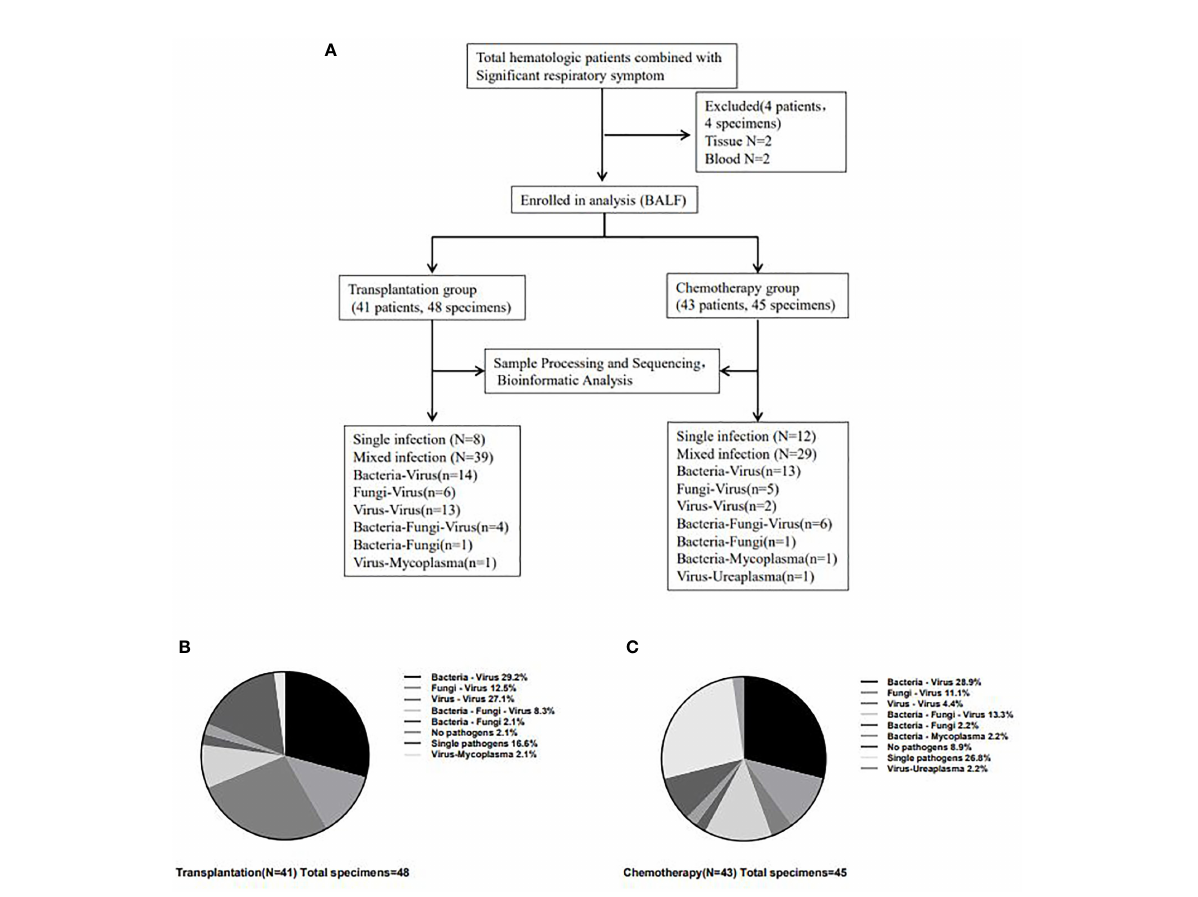
FIGURE 2 Detection of infectious pathogens by mNGS in transplantation group and chemotherapy group. The fl ow chart for inclusion of analyzed patients (A) and the most common type of infection in patients in the transplantation (B) and chemotherapy (C) groups was the mixed infection of bacteria-virus. And the mixed infection of virus-virus in the transplantation group was signi fi cantly higher than that in the chemotherapy group (27.1% vs 4.4%,